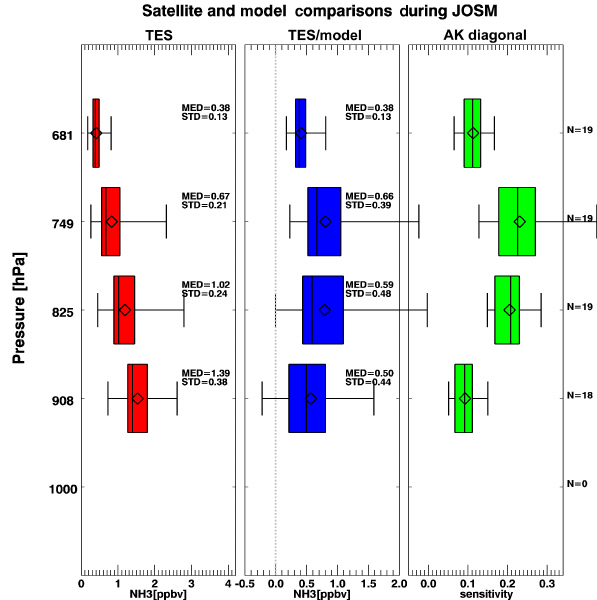
Figure 15. Single NH 3 profile GEM-MACH model/satellite com- parison and associated plots. (a) follows the same convention as Fig. 3, with the model profile replacing the aircraft profile (note since the model grey line is smooth it is obscured by the mapped blue line on the plot). (b) contains the difference between the TES- retrieved profile (purple) and the model profile (red). (c) contains the rows of the satellite averaging kernels at each retrieval level. (d) shows the 2-D simulated NH 3 model field at 956hPa that corre- sponds most closely to the TES overpass at 13:17LST. The profiles being compared are for the locations outlined in magenta, with the larger box showing the TES footprint and the smaller inner box the model grid box.